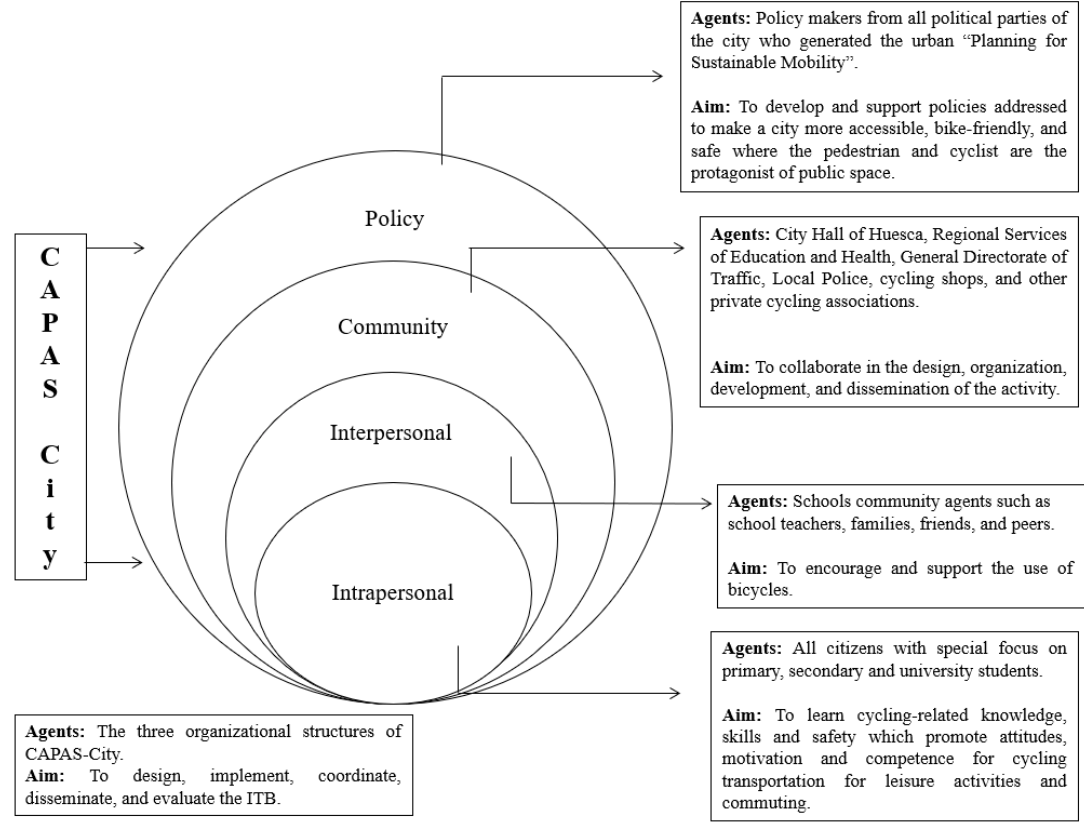
Figure 4. Agents involved and objectives at each level of influence of the Social-Ecological approach for the ITB.